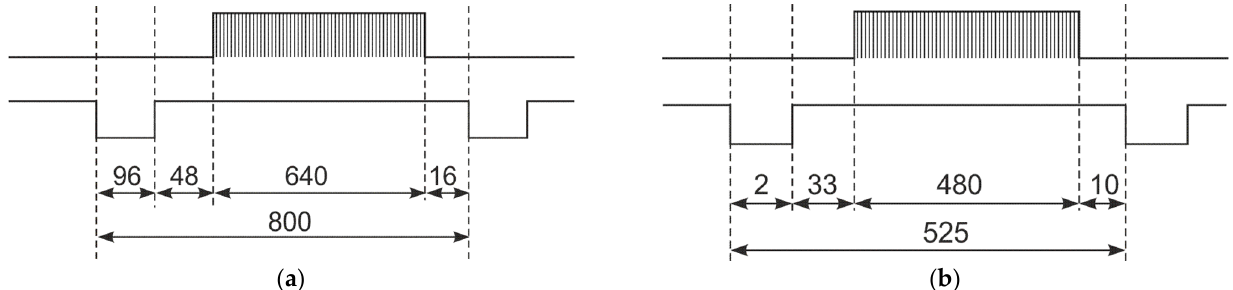
Figure 1. Timing relationships between video signals and ( a ) horizontal and ( b ) vertical sync signals for VGA monitor (video graphics array) operating in 640 × 480/60 Hz mode.